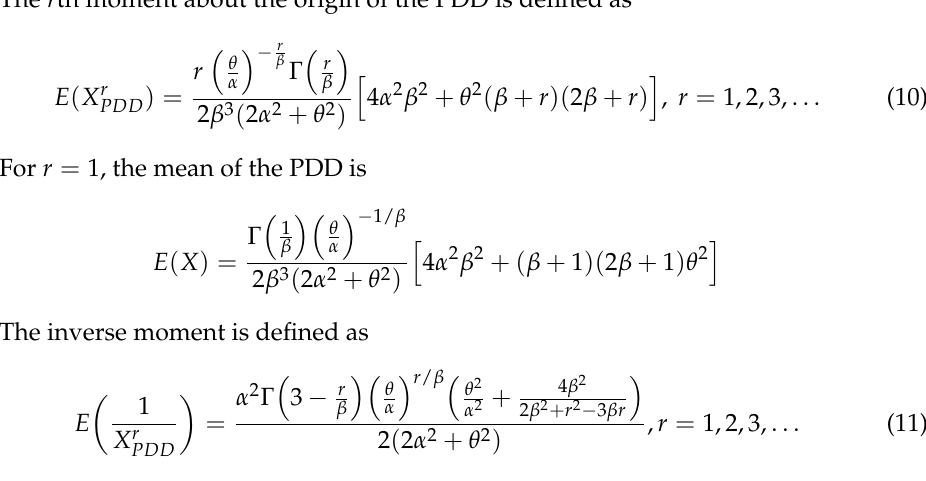
In Table 1: the mean ( µ X ) , coefficient of variation ( υ X ) , standard deviation ( σ X ) , and coefficient of skewness ( δ X ) of the IDD for selected values of